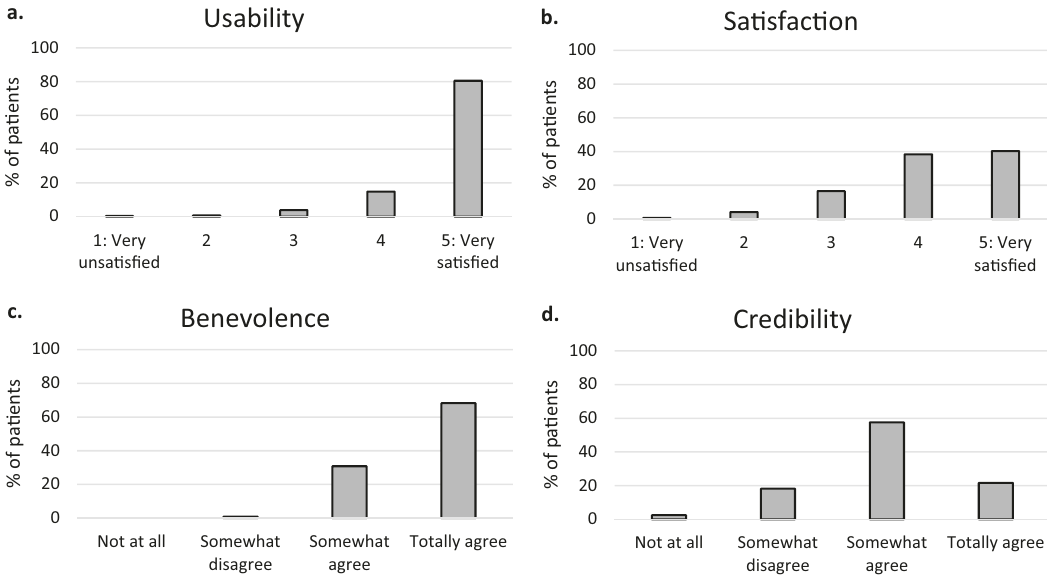
Fig. 1 Distribution of usability, satisfaction, benevolence, and credibility perception. a percentage of patients ’ rating for usability dimension (AES sub-score), b percentage of patients ’ rating for satisfaction dimension (AES sub-score), c percentage of patients ’ rating for benevolence dimension (ETQ sub-score), d percentage of patients ’ rating for credibility dimension (ETQ